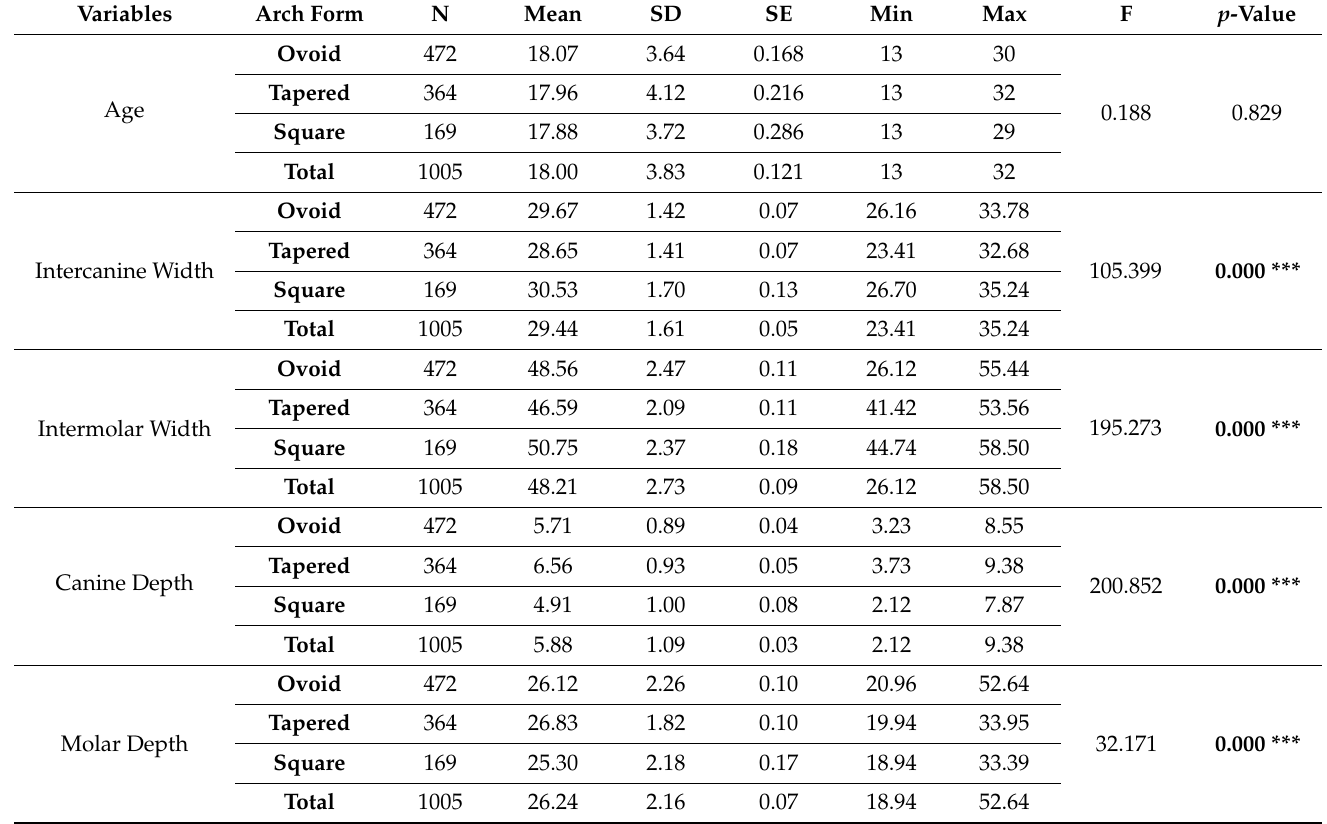
Table 7. Descriptive statistics and comparison of age and arch dimensions among arch forms (ANOVA